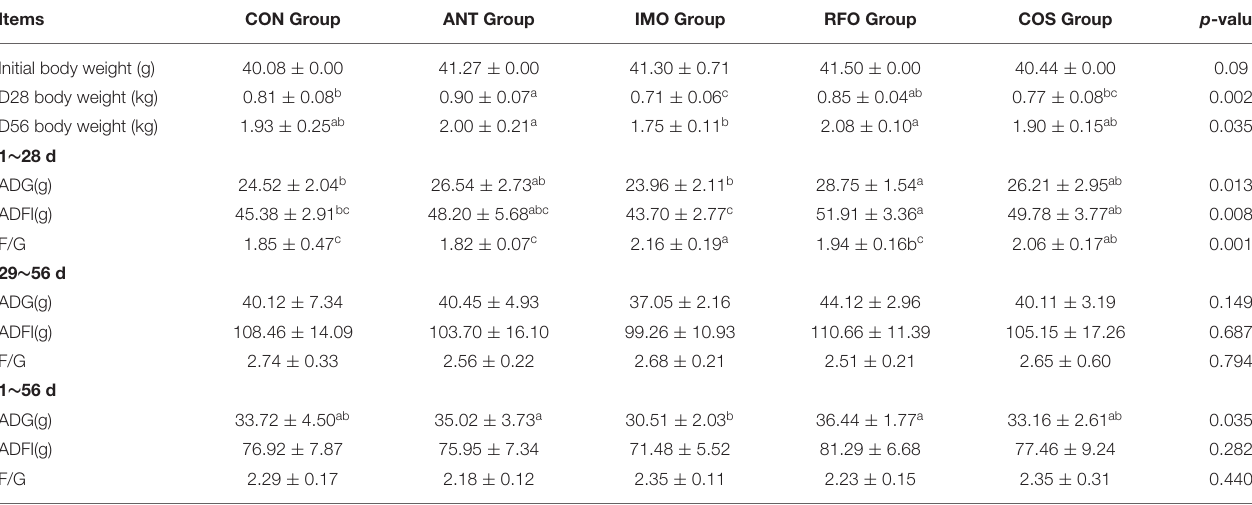
TABLE 3 | Effects of different oligosaccharides on growth performance of broilers. Items